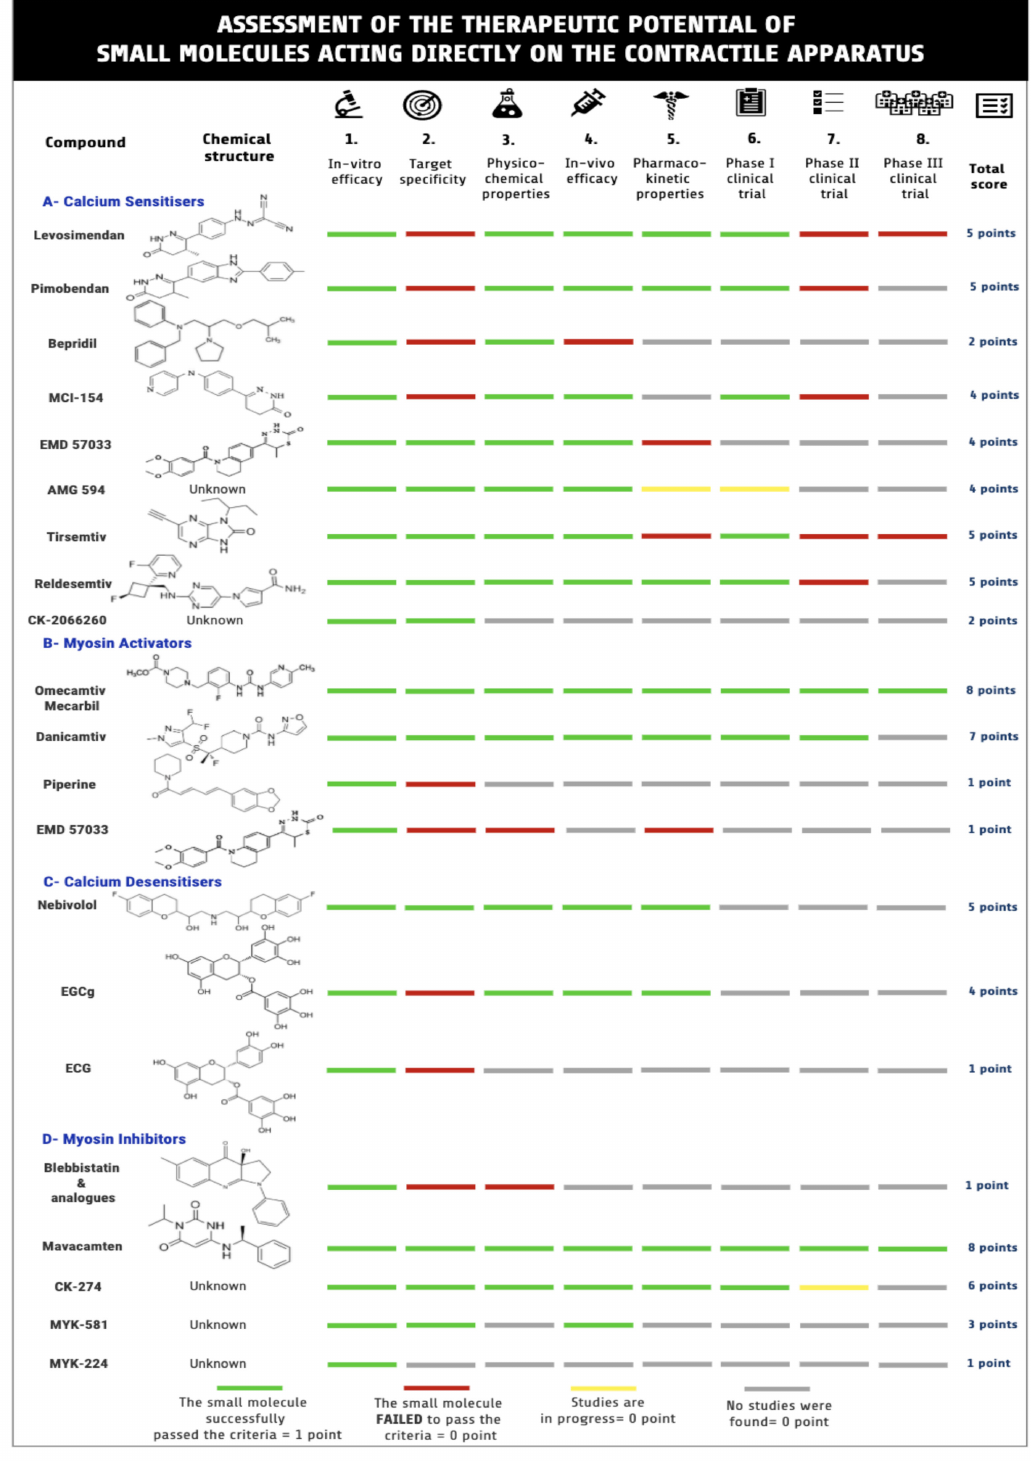
Figure 2. Assessment of therapeutic potential of small molecules that act on the contractile apparatus. Searches of the literature yielded 21 compounds worth further consideration. The compounds were evaluated and scored according to eight di ff erent criteria summarised in the figure. Created by using Venngage infographic